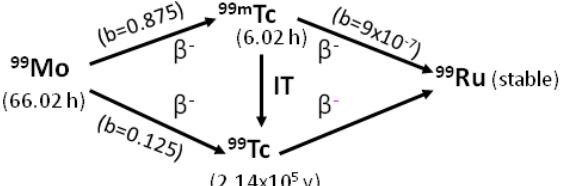
and t are the opt ( t ) opt ( SA )